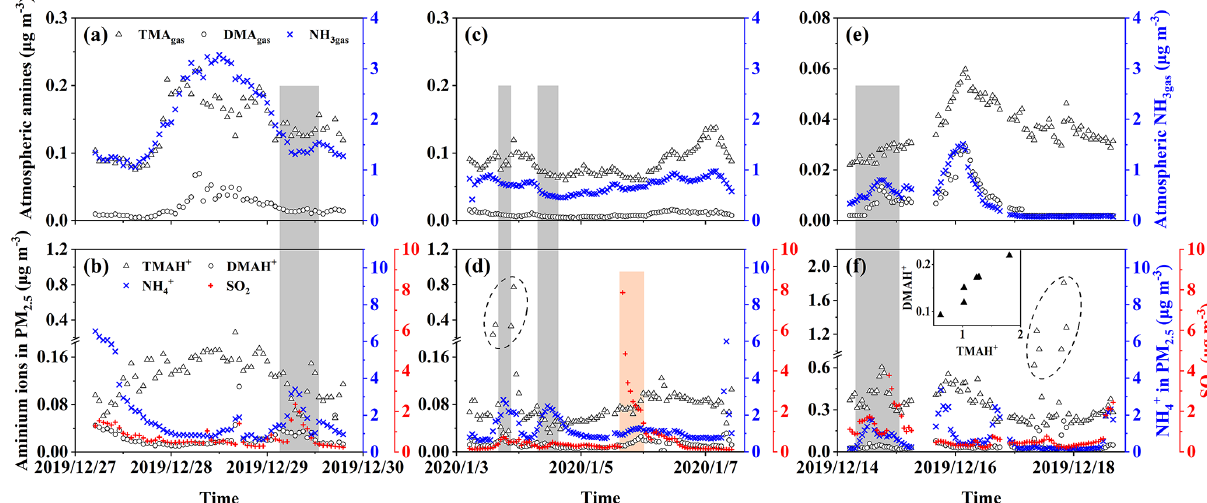
Figure 4. Time series of concentrations of gases and particulate ions during three episodes. Basic gases in E-period 1 (a) ; particulate ions and SO 2 in E-period 1 (b) ; (c) and (d) are the same as (a) and (b) except in E-period 2; (e) and (f) are the same as (a) and (b) except in E-period 3; gray and pink shadowing represents episodes with increasing NH + or SO 2 , respectively; the figure superimposed in (f) shows 4 the correlation between TMAH + and DMAH + in six cycling points in (f)